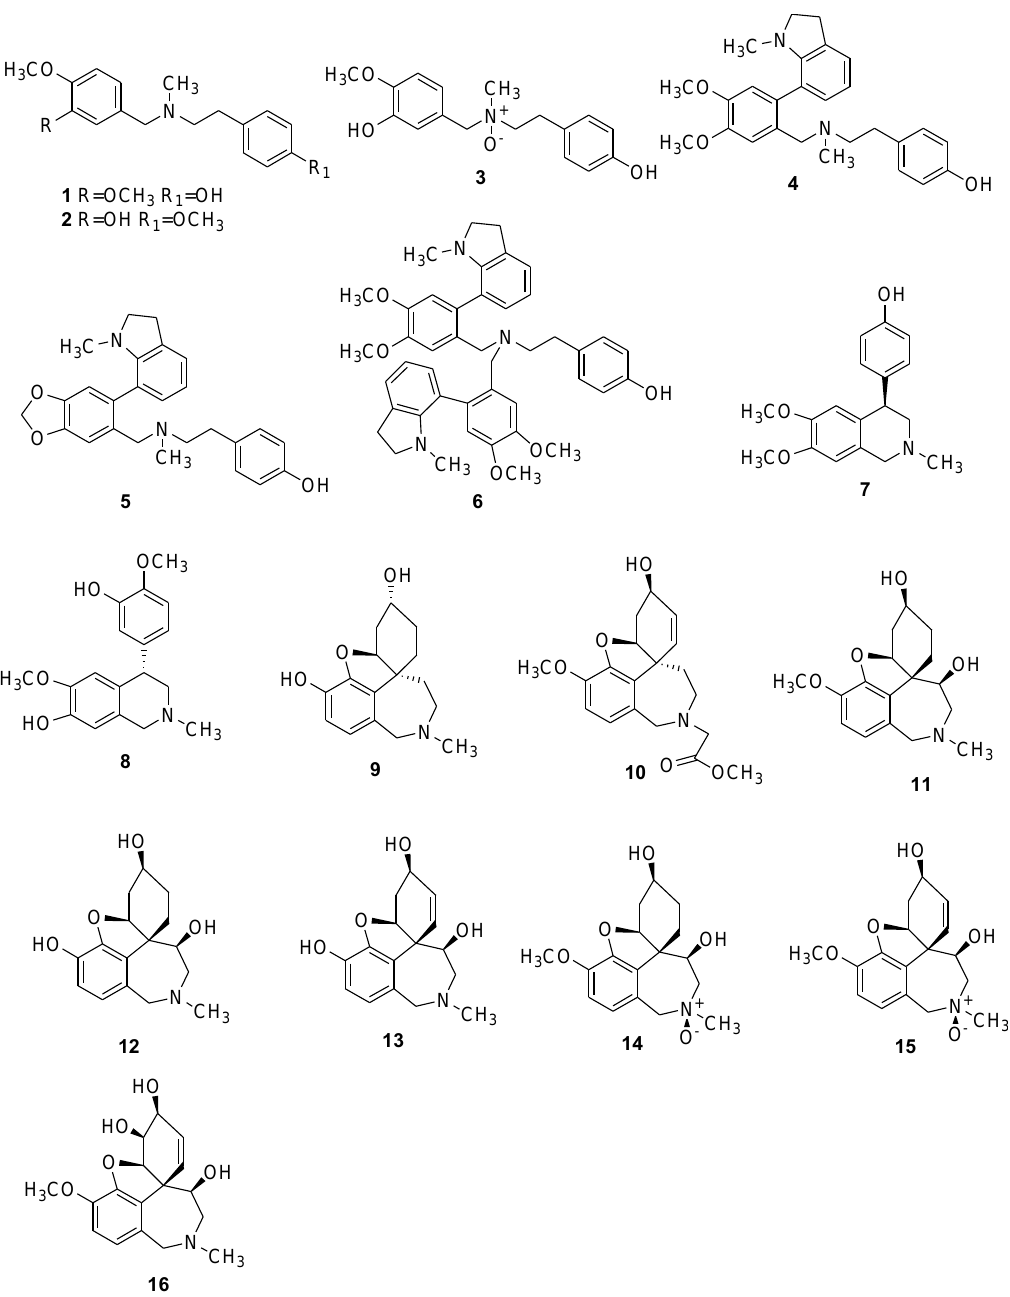
Figure 3. Chemical structure of novel Amaryllidaceae alkaloids of the norbelladine- ( 1 – 6 ), cherylline ( 7 – 8 ) and galantamine-type ( 9 – 16 ). Numbers in bold refer to the compounds depicted in Table 2. Twenty species are included in the genus Galanthus native of Europe and of Middle East [91].